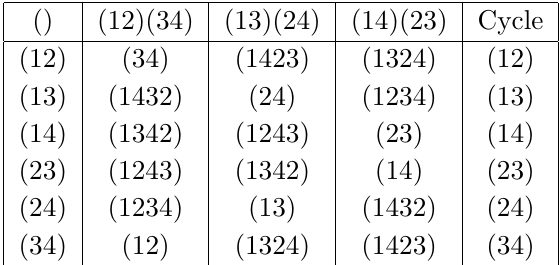
g by 2-cycles. (4)